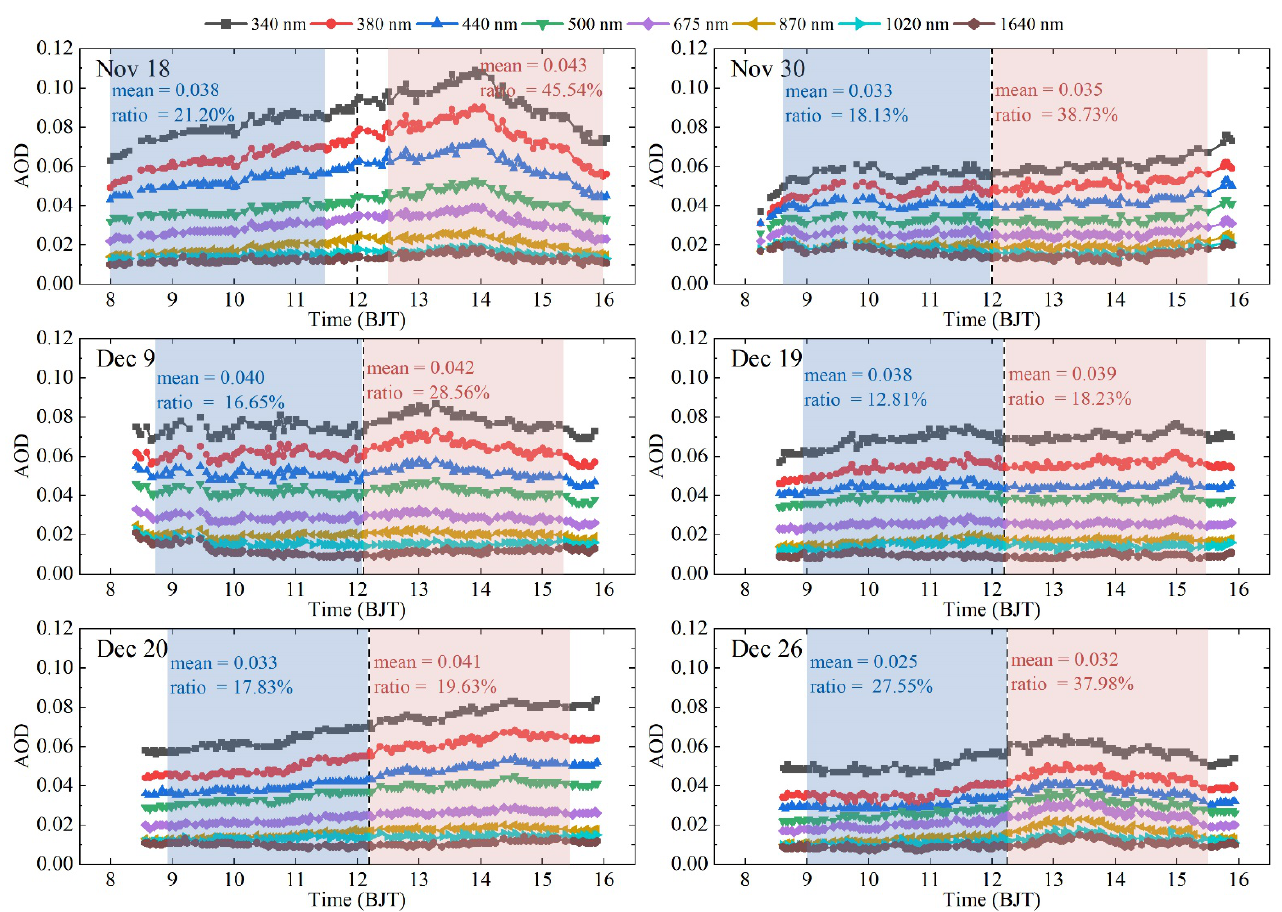
Figure 8. The diurnal AOD derived from the measured data on the six study days based on the final V 0 λ values. The blue and red shaded areas represent the observation time under an air mass of 2–5 in the morning and afternoon, respectively.